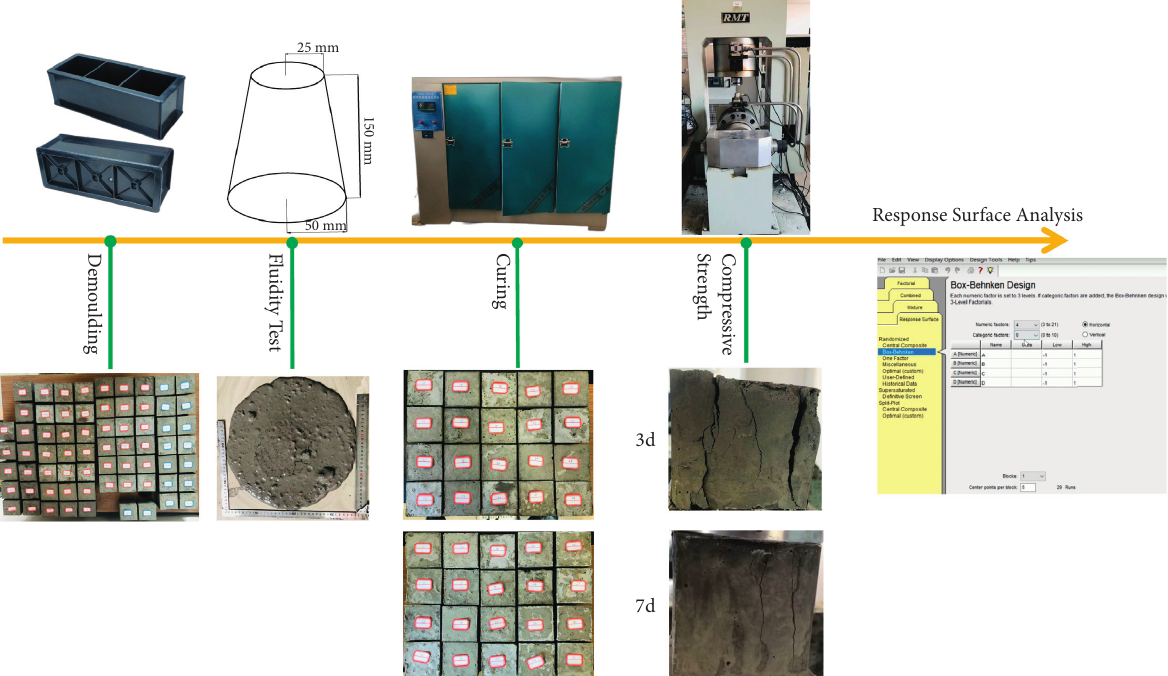
Figure 5: Test flow chart of coal-based solid waste filling material. Table 2: Response surface design and